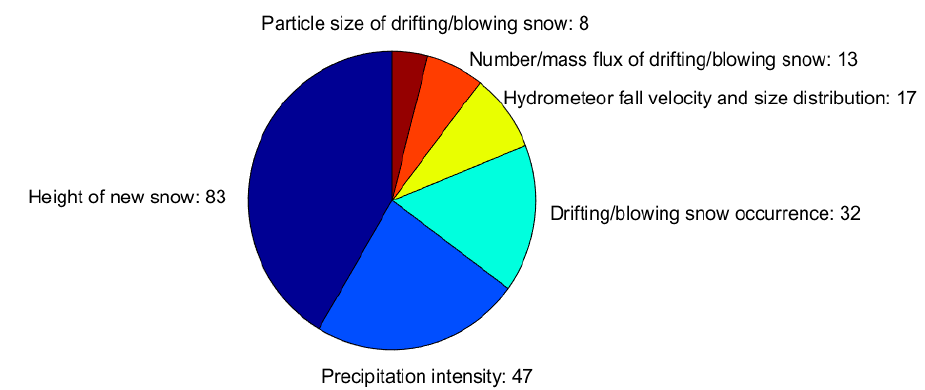
Figure 11. Measured precipitating and suspended snow properties. The width of each slice corresponds to the fraction each precipitating and suspended snow property has, relative to the total number of reported precipitating and suspended snow properties (i.e., the sum of the numbers given in the